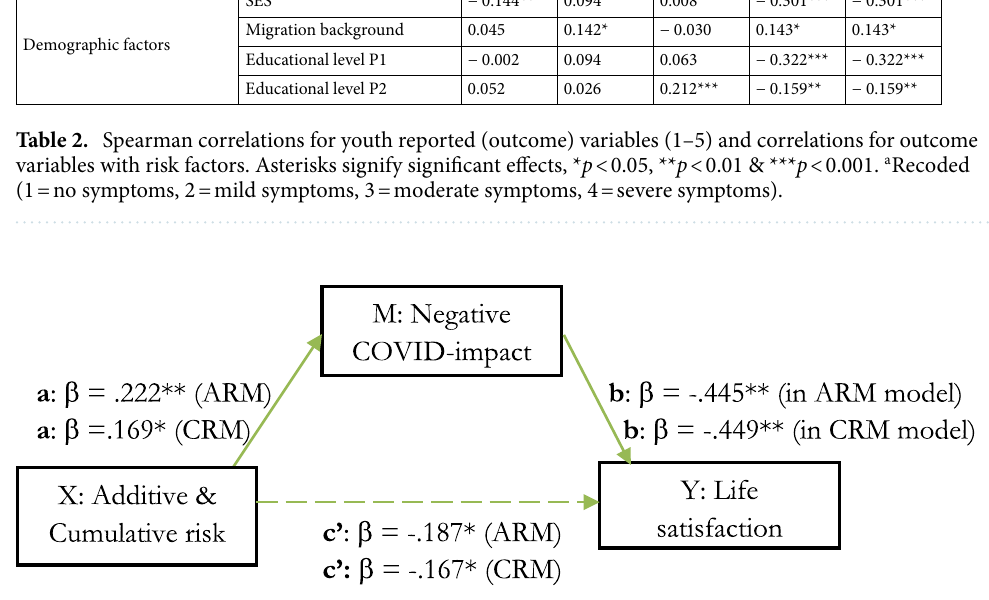
Figure 1. Mediation effects. ARM/CRM → Negative COVID-impact → Life satisfaction. Note. Green arrow = significant, dashed = significant in separate model, but non-significant when negative COVID-impact is added to the model; * p < 0.01 & ** p <